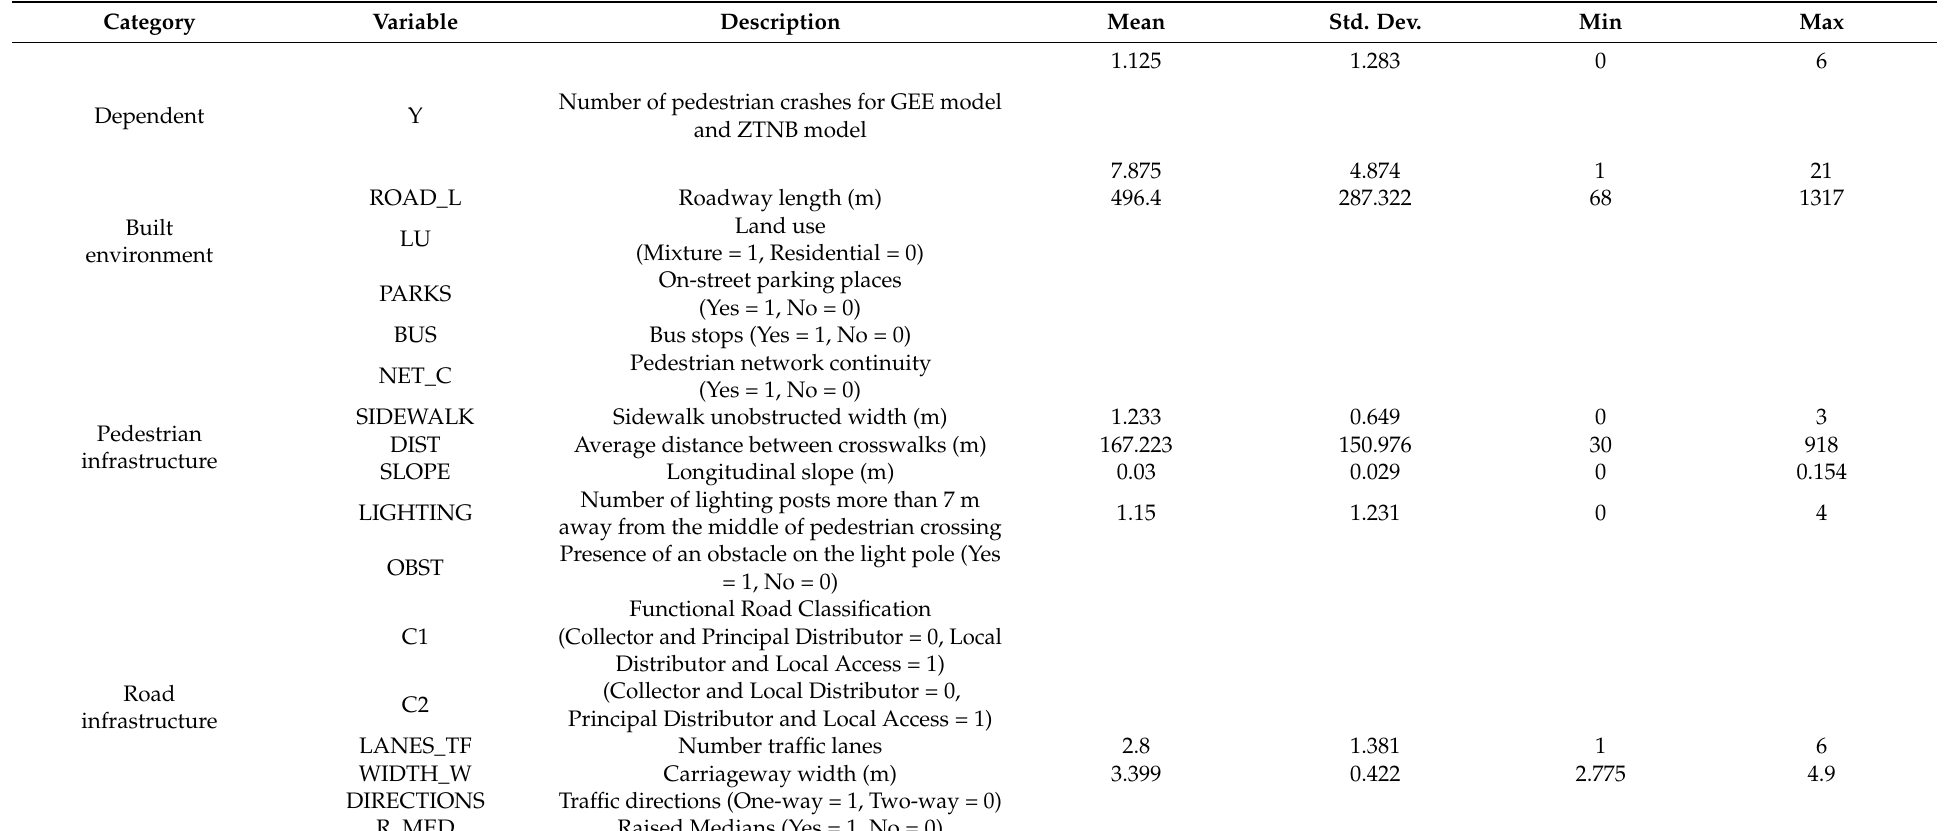
Table 2. Model dependent and explanatory